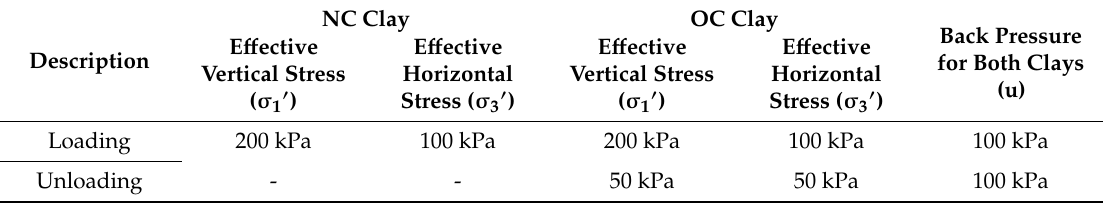
Table 2. Loading and unloading conditions during the consolidation